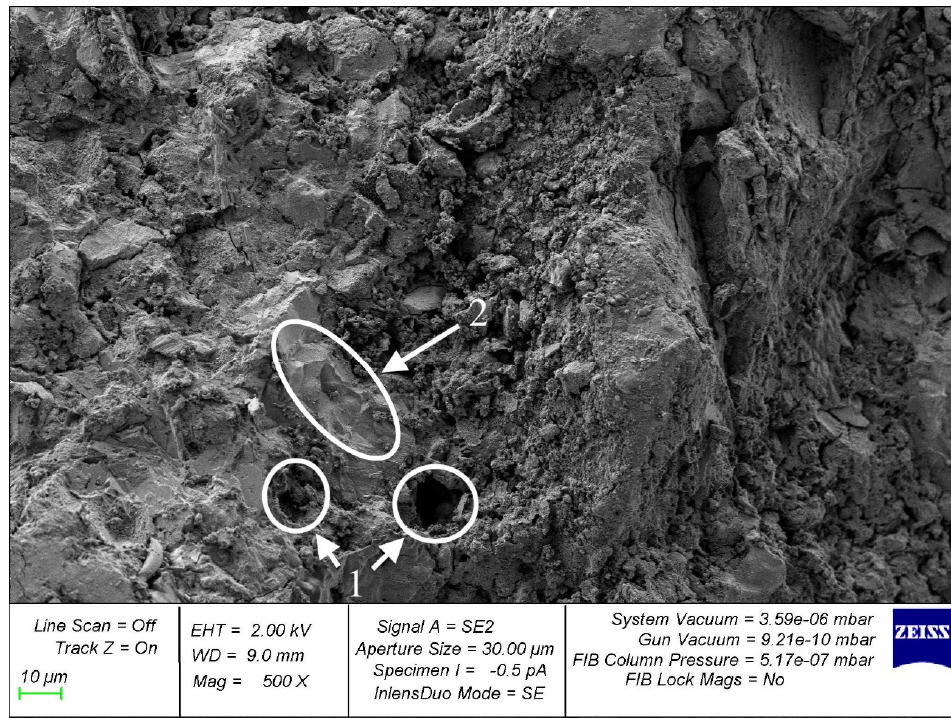
Figure 13. Sample with 4% snail shell powder dosage (1—porosity, 2—binder phase). Appl. Sci. 2022 , 12 , x FOR PEER REVIEW